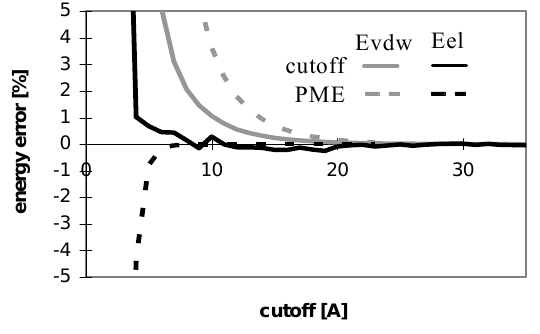
Figure 1. Dependency of energy error on cutoff (for protein P7). Energy error ( EE ) is calculated using the equation: EE = 100.(E – E f )/E f , where E is the energy value calculated for the cutoff and E f is the final energy (see method section).